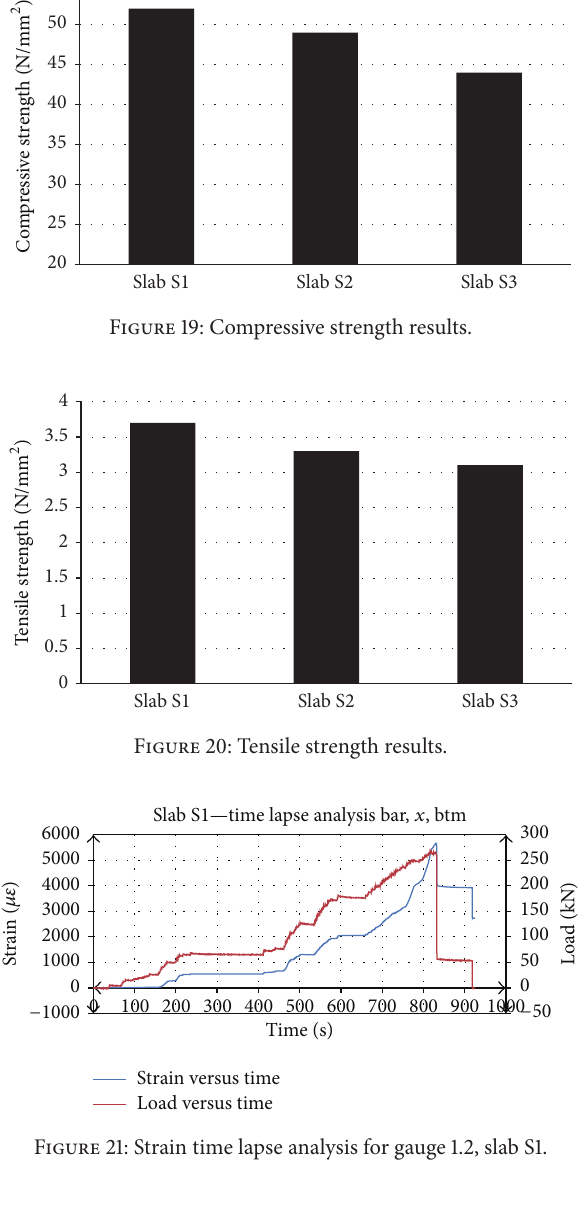
Figure 21: Strain time lapse analysis for gauge 1.2, slab